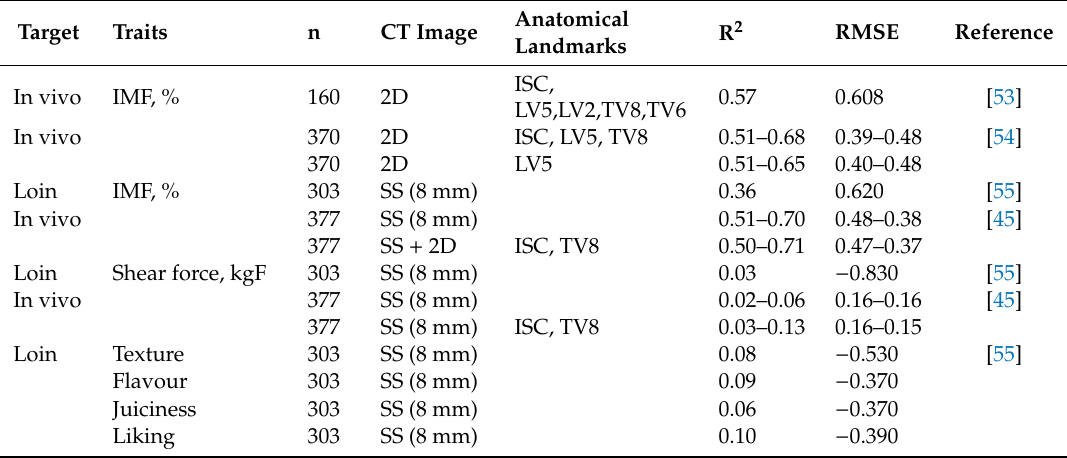
Table 3. Summary of applications of computed tomography imaging for prediction of meat quality attributes of